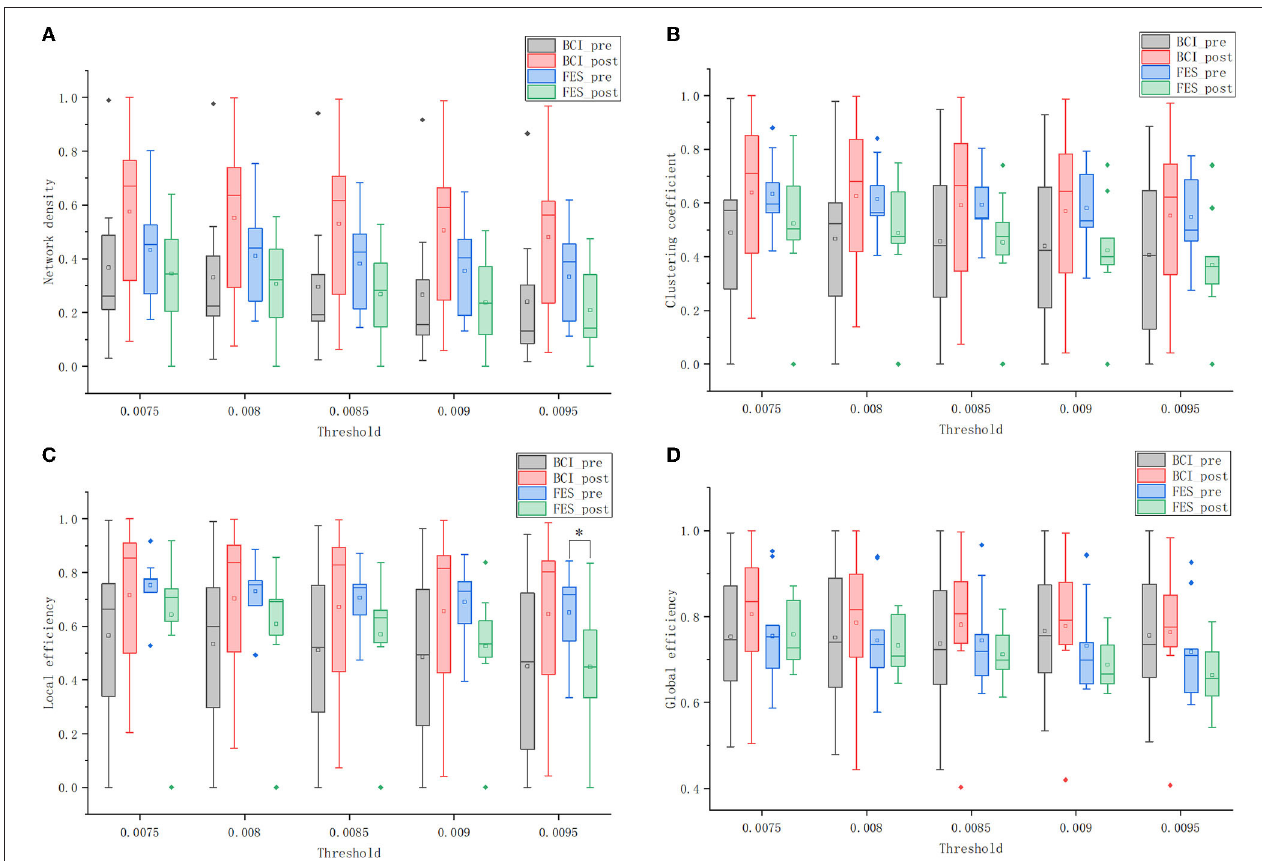
FIGURE 8 | Global graph theory measures of the brain networks of the two groups before and after the intervention at different thresholds. (A) network density; (B) clustering coefficient; (C) local efficiency; and (D) global efficiency. Solid diamonds indicate outliers. Hollow squares represent mean values. * p <